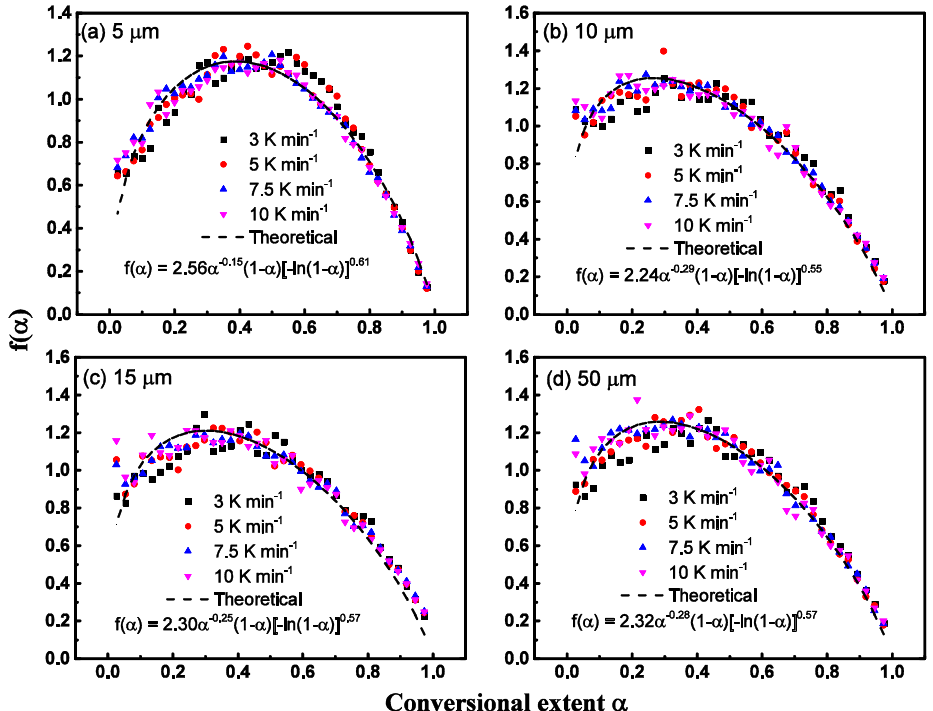
Figure 5. The experimental kinetics function f ( α ) reconstructed from isoconversional kinetic method of polystyrene pyrolysis for 3, 5, 7.5, and 10 K · min − 1 heating rates. The dash line means the reconstructed profile of modified Avrami–Eroféev reaction model.